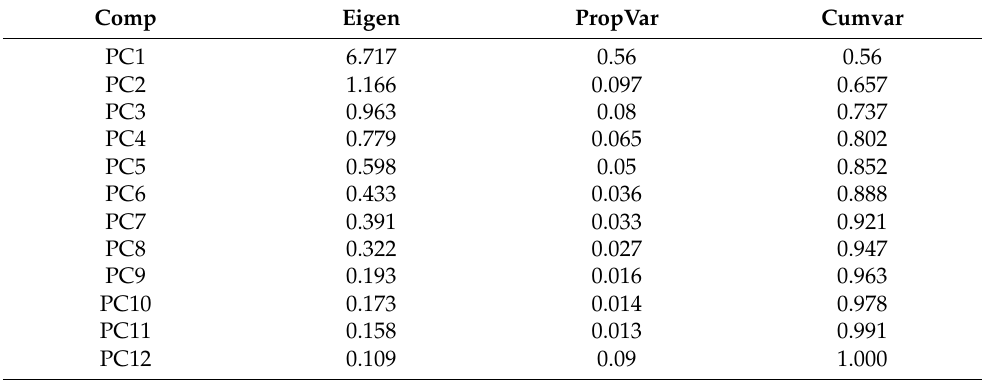
Table 2. Principal components analysis of the 12 conifer chronologies from the Borderlands region of Texas and Mexico,